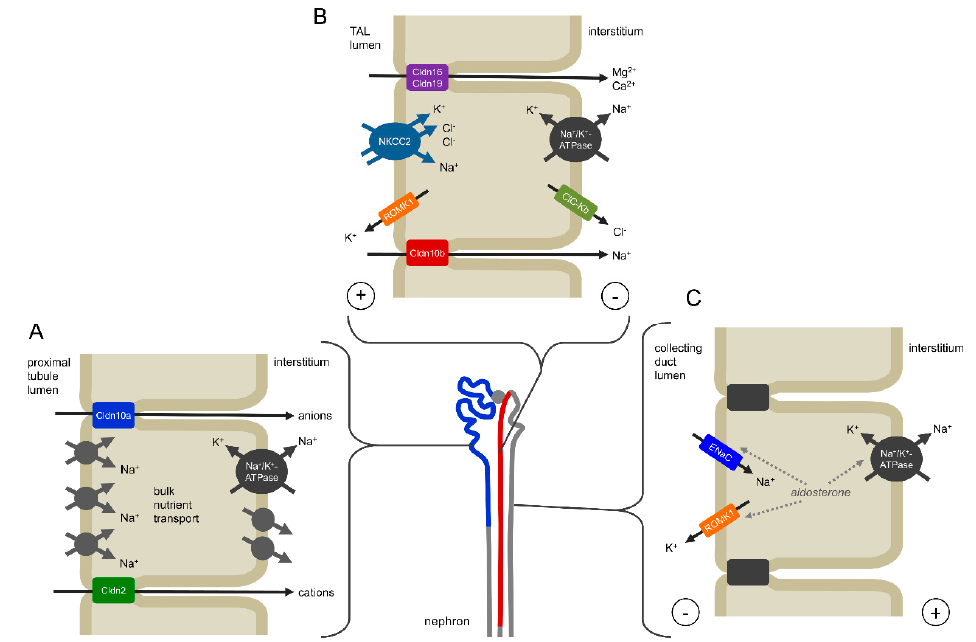
Figure 3. Mechanisms of claudin-10 function in the kidney. ( A ) Claudin-10a is expressed in the renal proximal tubule to the S3 segment (shown in blue) where it forms a paracellular anion pathway. Patients with pathogenic variants of both claudin-10a and claudin-10b appear to have no clinical manifestations different from patients with only claudin-10b variants, suggesting a minor role of an impaired claudin-10a function and / or compensation in more distal nephron segments. ( B ) Claudin-10b is mainly localized in the thick ascending limb of Henle’s loop (TAL, shown in red) where it facilitates the paracellular reabsorption of Na + . Na + , 2 Cl – and K + enter the epithelial cell by the secondary active NKCC2 transporter. Whereas Na + and Cl – leave the cell basolaterally, K + is recirculated via the